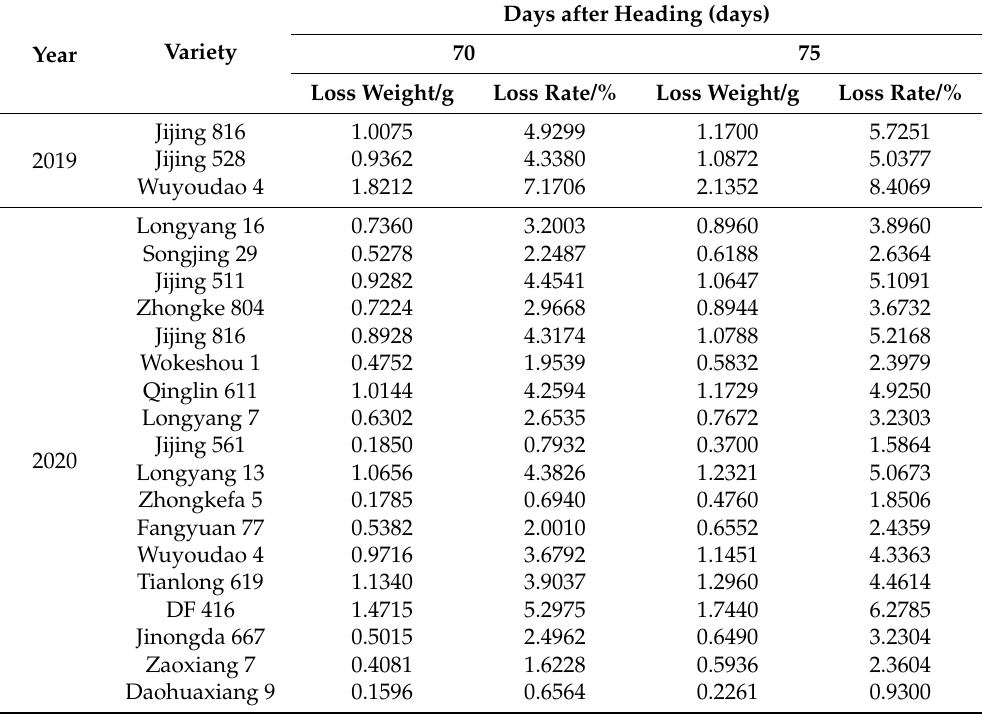
Table 2. Latent loss weight and dry matter loss rate based on a standard 15% moisture content.